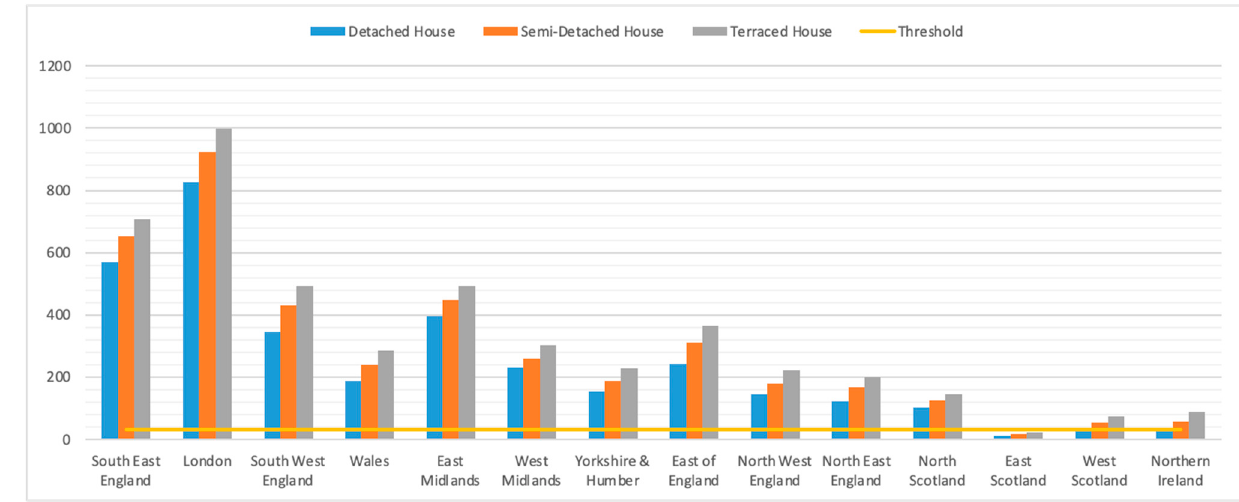
Figure 5. Base model annual bedroom overheating with PROMETHEUS 2030s, medium emissions climate data; line shows 32 h overheating threshold.